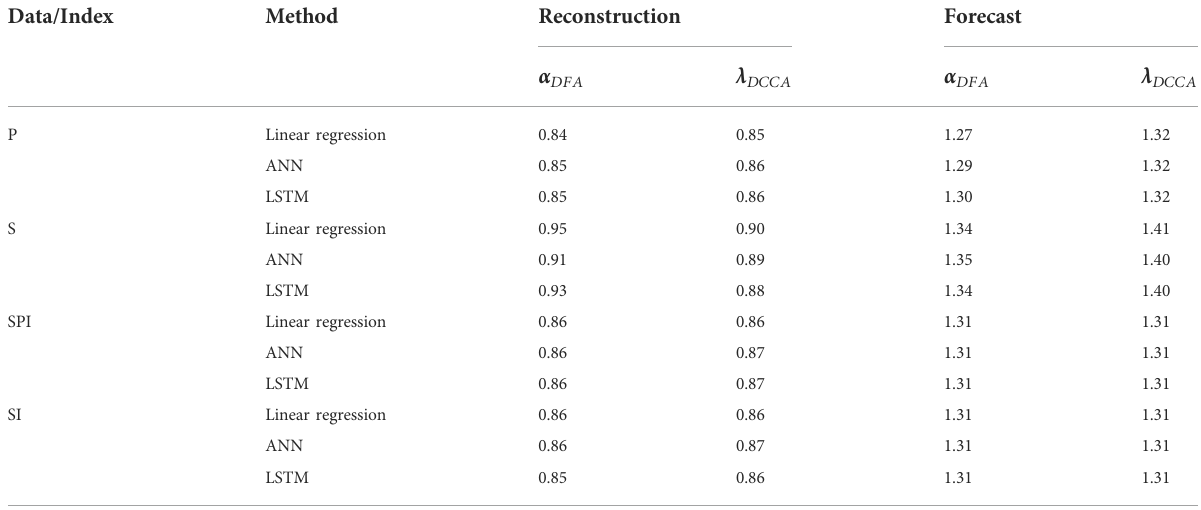
TABLE 4 α DFA of different reconstructed and forecasted runoff at the TC-CD station and λ DCCA of different reconstructed and forecasted runoff against the TC-CD station. Data/Index